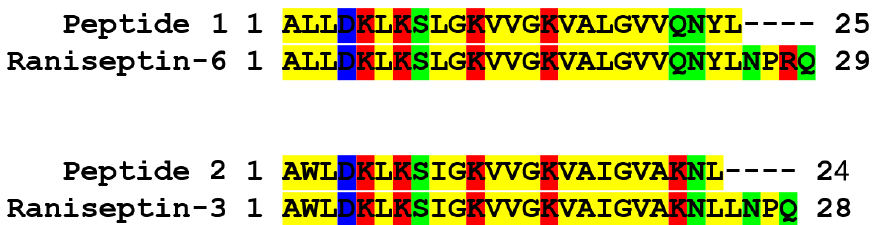
Figure 4. Alignment of peptides 1 and 2 (directly sequenced) isolated from B. raniceps skin secretion with the predicted amino acid sequences for the Raniseptins-3 and -6 identified in the B. raniceps cDNA library.